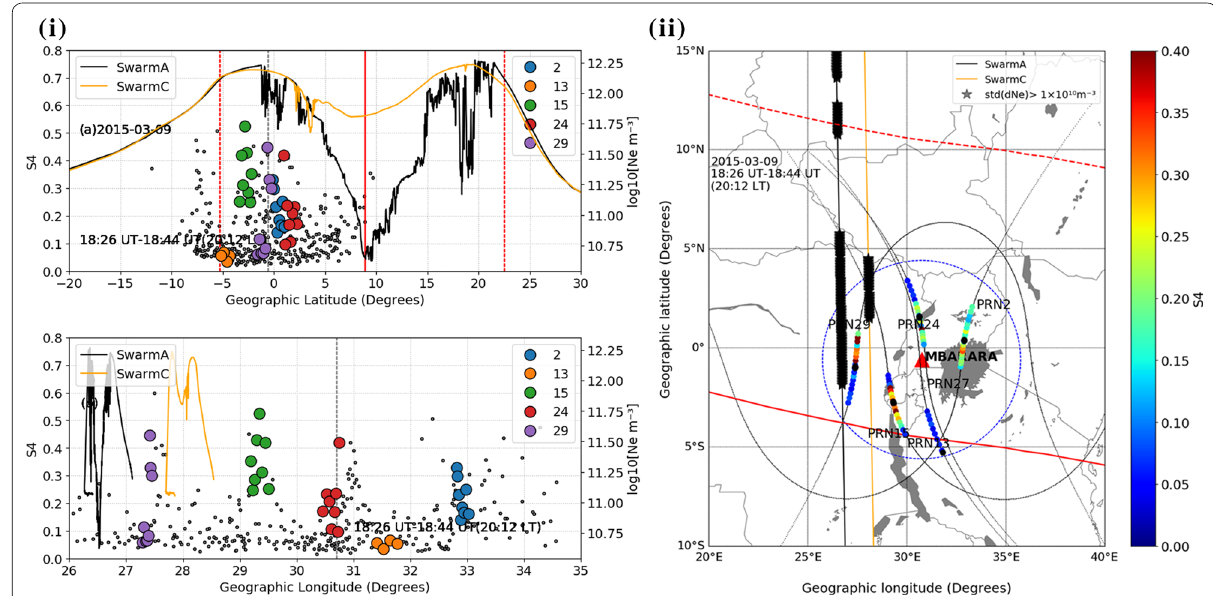
Fig. 2 Panel (i): the N e perturbations for Swarm A and C and S 4 at Mbarara on 2015-03-09. The red solid vertical line represents the magnetic equator, the red dashed vertical lines represent the EIA belts at approximately ± 15 ◦ magnetic latitudes, the gray dashed vertical lines represent the Mbarara latitude and longitude. The N e measurements are shown as colored lines with the y-axis to the right, while the S 4 index values from GPS satellites in view are presented as colored dots identified by their PRN with the y-axis to the left. The S4 for all the GPS IPPs in view are shown with black dots in panel (i)(a) and (b). Panel (ii): tracks of PRN 2, 13, 15, 24, and 29 including Swarm A and C tracks on 2015-03-09. The location of Mbarara GPS-SCINDA is indicated with a red triangle. The portions of the Swarm A and C tracks marked in black correspond to regions where ionospheric irregularities were encountered. Points along the GPS satellite tracks corresponding to the average local time when the Swarm satellites were in view are presented with black dots. The blue circle is a projection of the 30° elevation centered at MBAR indicating regions in which scintillations were